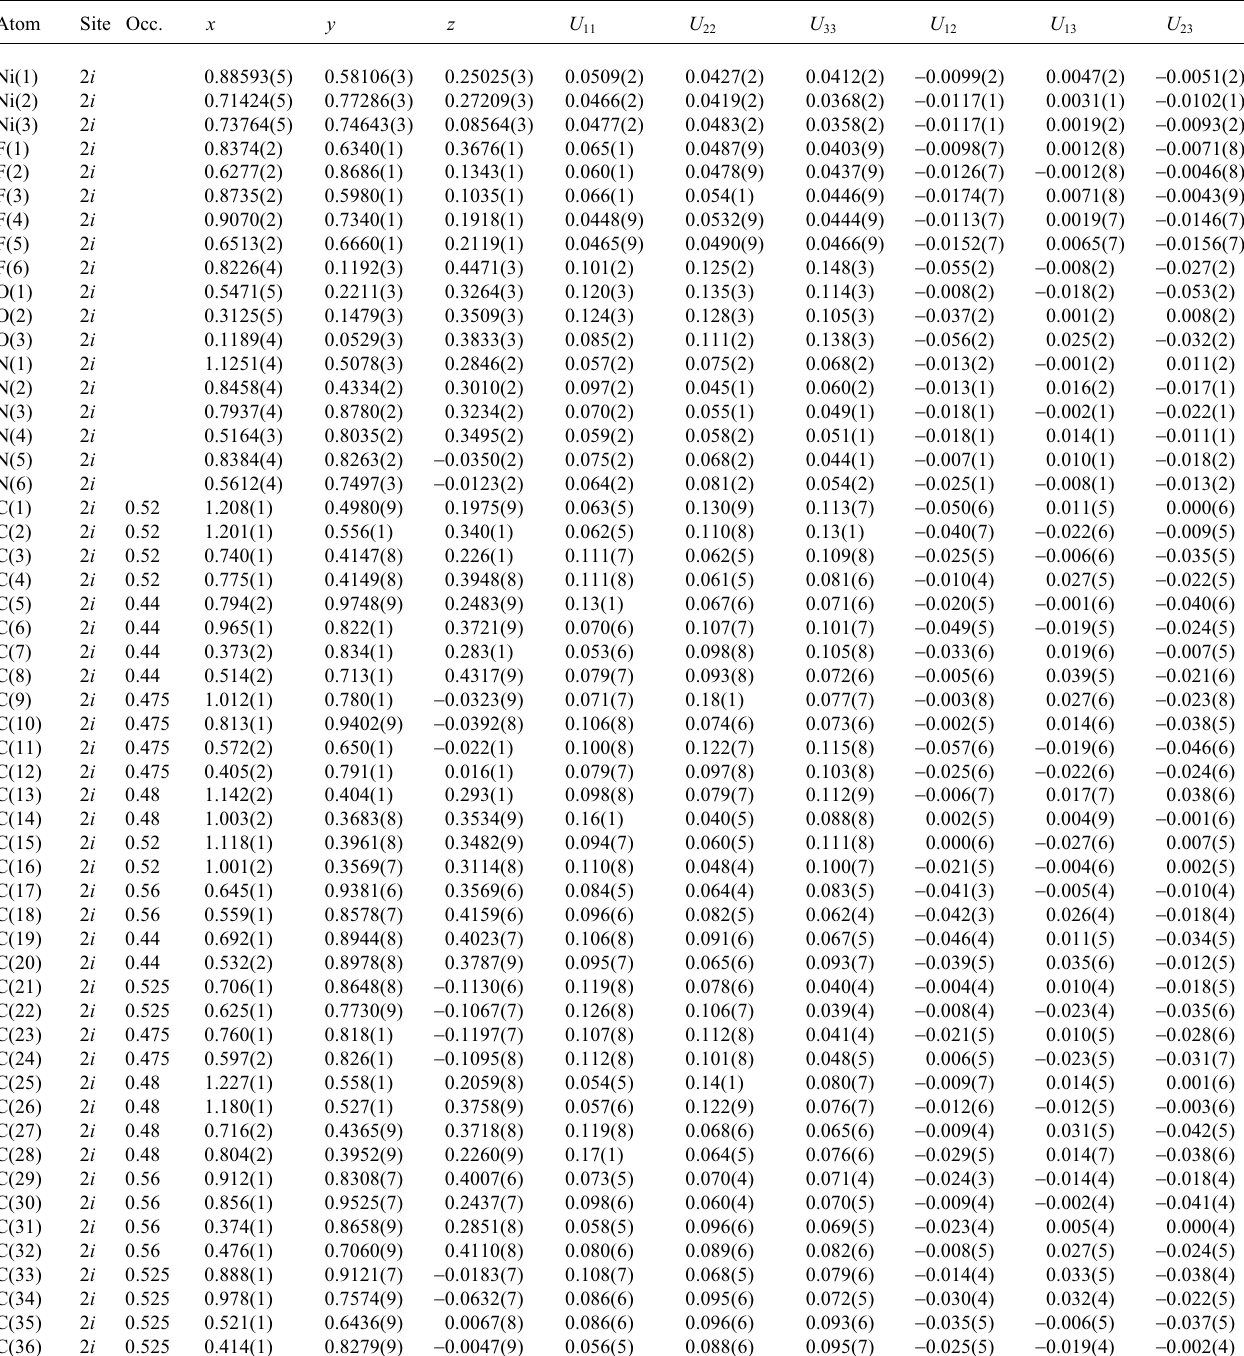
Table 2. Atomic coordinates and displacement parameters (in Å 2 )